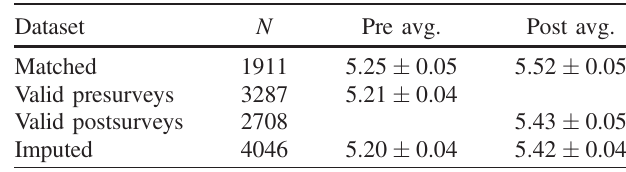
TABLE XII. Average scores for datasets containing only matched students, all valid responses, and the complete set of students including imputed